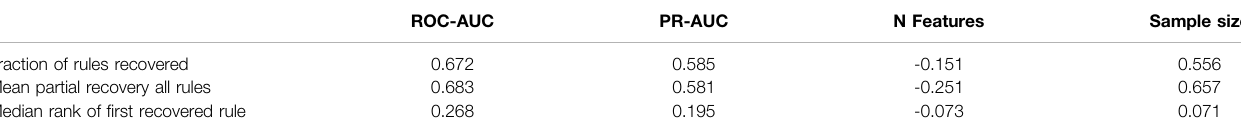
TABLE 1 | Correlation of performance metrics and data dimensions with rule recovery.